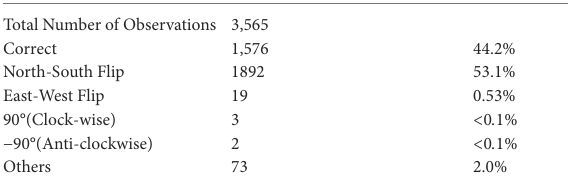
TABLE 1 Number of observations for different flags representing the orientation of the images during